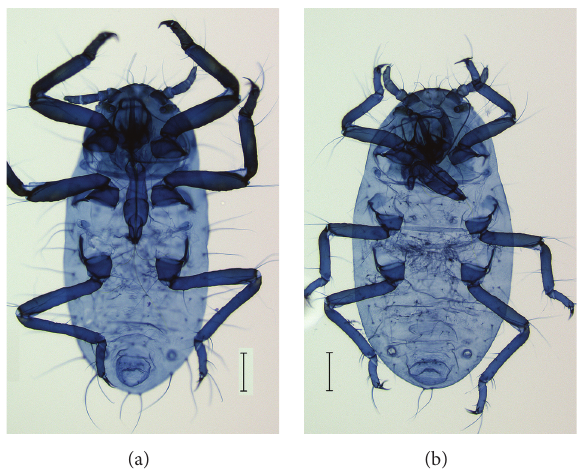
Figure 3: First-instar nymphs of the alate generation of Thoracaphis kashifolia : (a) typical defensive nymph with enlarged fore- and mid-legs (Tama, Tokyo; 29 September 2015); (b) first-instar nymph produced early in autumn (Tama, Tokyo; 4 September 2015). Scale bars: 100 𝜇